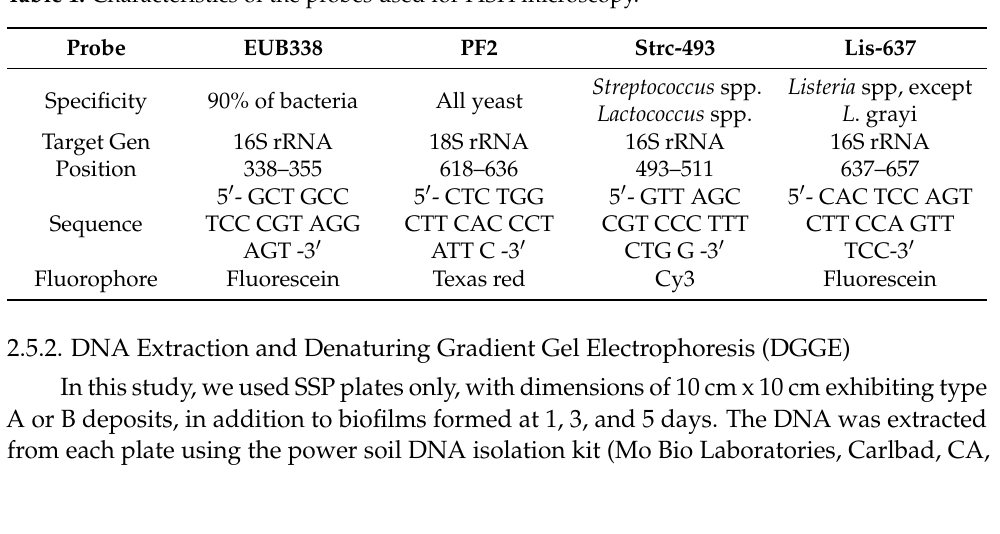
Table 1. Characteristics of the probes used for FISH